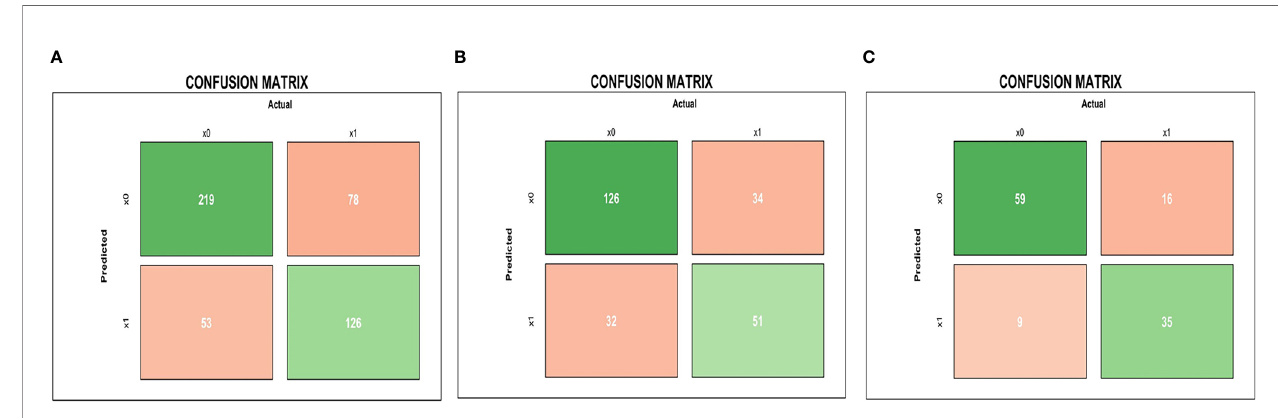
FIGURE 3 | Pre-treatment MRI-radiomics model in each dataset predicted the confusion matrix of PFS in LA-NPC. (A – C) represent the confusion matrix of the MRI- radiomics model of pre-treatment in the training dataset, the original dataset, and the test dataset,